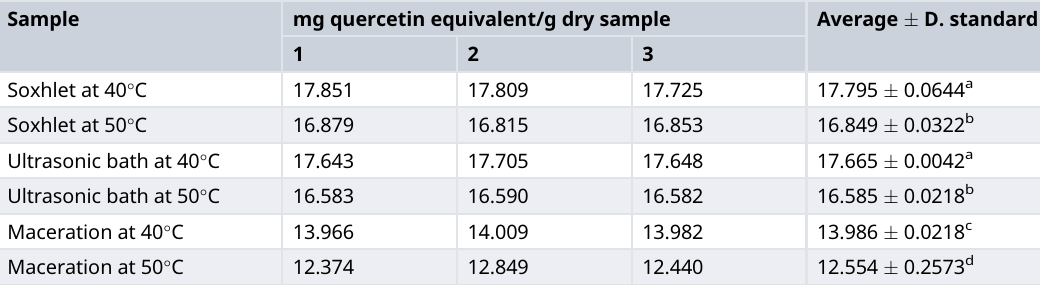
Table 7. Total flavonoid content corresponding to quercetin